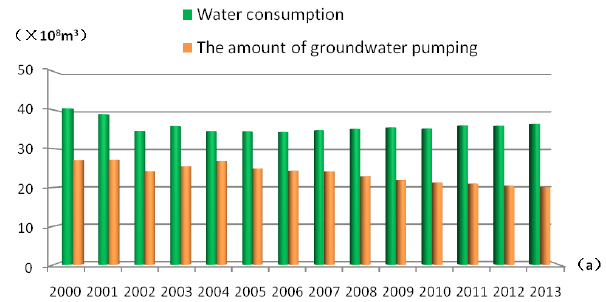
Figure 3. Water consumption and amount of groundwater pumping in Beijing